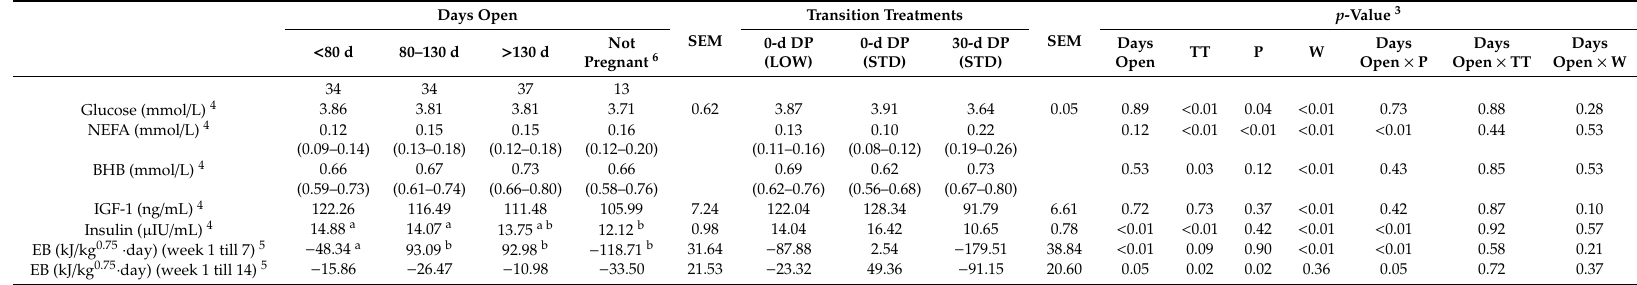
a,b Values with di ff erent superscripts di ff er ( p < 0.05). 1 Postpartum = weeks 1 to 7 after calving, unless otherwise stated; 2 Transition treatments were: 0-d dry fed low energy level postpartum (0-d(LOW)); 0-d dry fed a standard energy level postpartum (0-d (STD)); 30-d dry fed a standard energy level postpartum (30-d (STD)); 3 TT = Transition treatments; P =